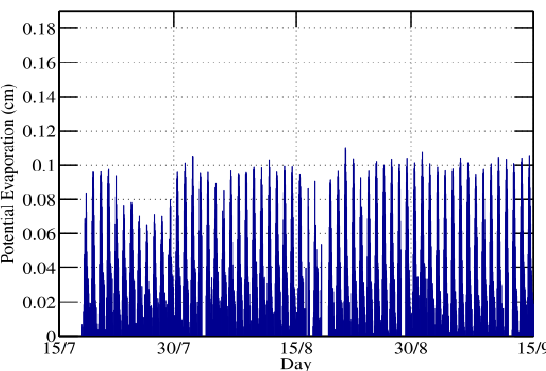
Figure 9. Estimated potential evaporation during the field experiment.